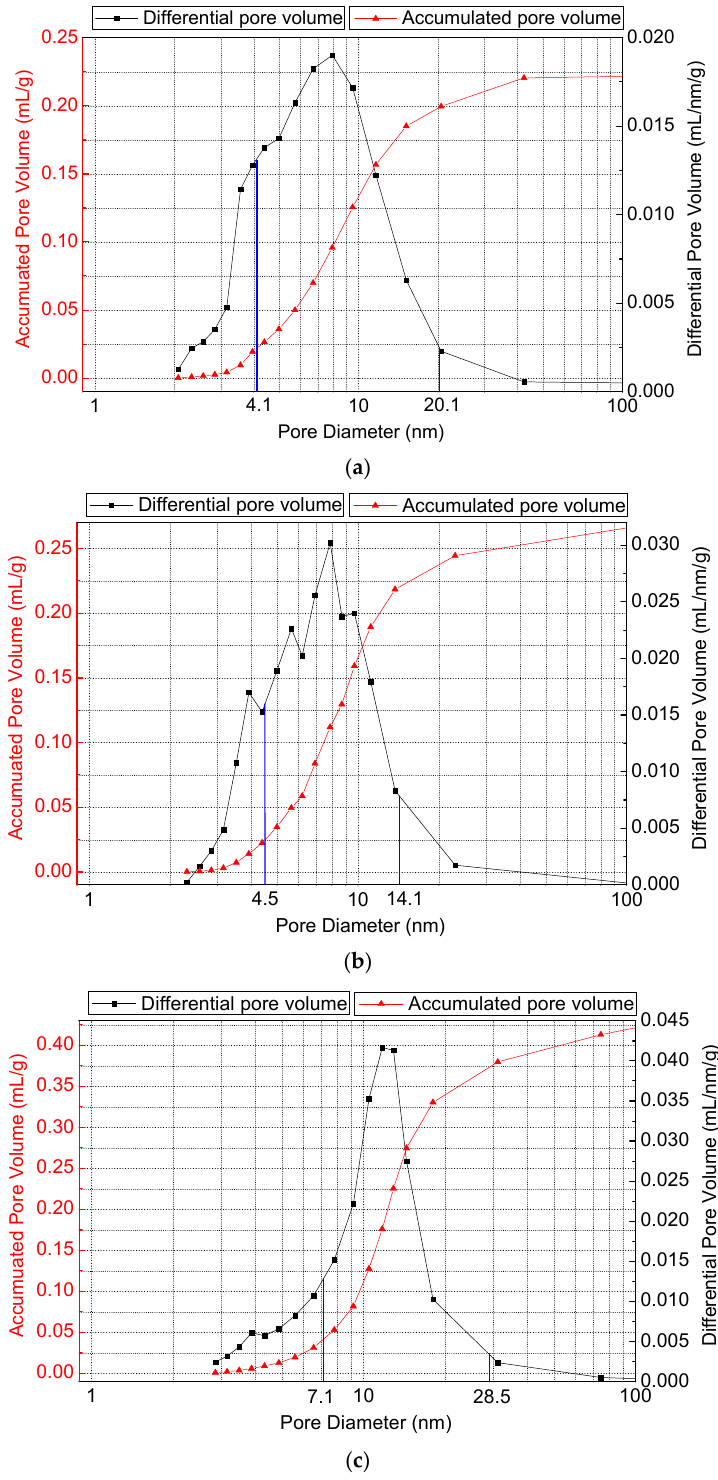
Figure 2. The pore size distribution curves of samples #1, #2, and #3; ( a ) sample #1, ( b ) sample #2, ( c ) sample